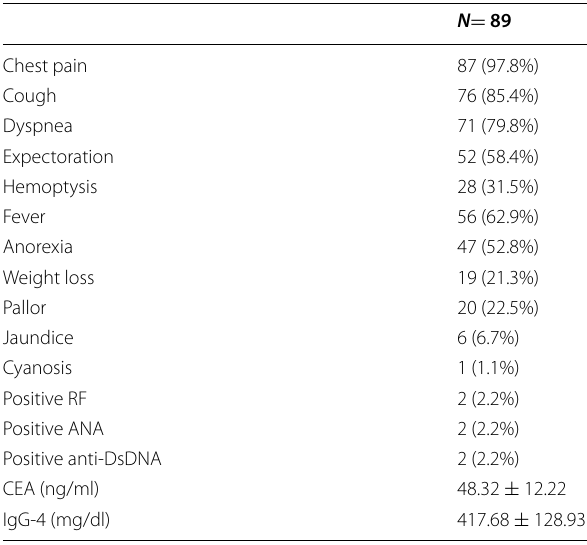
Table 2 The baseline of clinical and laboratory data of enrolled